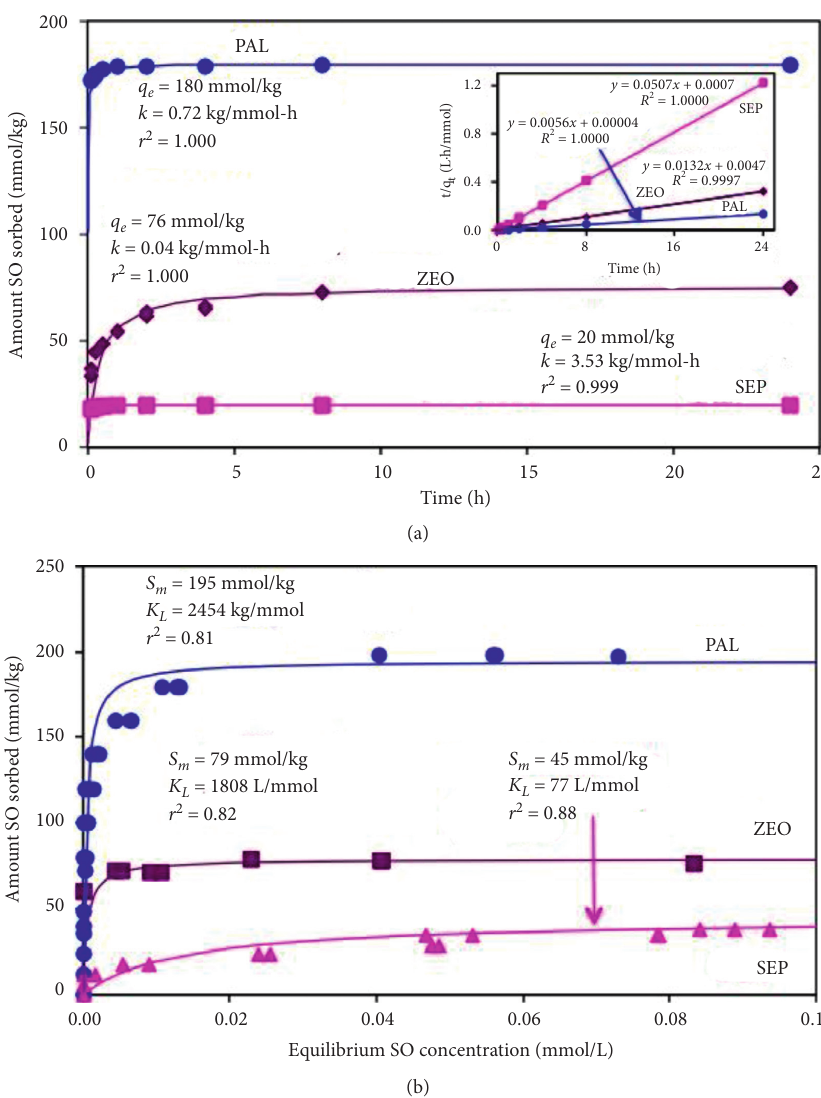
Figure 2: Kinetics (a) and isotherm (b) of SO sorption on PAL, ZEO, and SEP. The lines are pseudo-second-order (a) and Langmuir (b) fits the experimental data. Inset in (a) is linearized fit to the pseudo-second-order